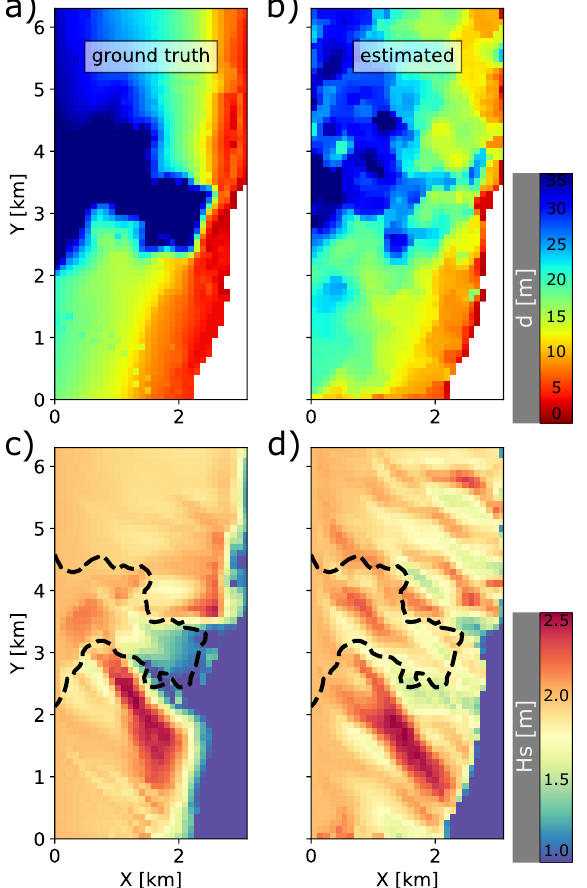
Figure 7. Predicted wave height distributions over ground truth bathymetry and estimated bathymetry of Capbreton using a numerical wave model: ( a , b ) ground-truth depths and estimated depths, respectively, used in the model, where red/blue indicate shallow/deep regions (top colorbar). Salt-and-pepper noise has been removed from ( b ) using a 3 × 3 median filter; ( c , d ) significant wave height distribution associated to ( a , b ), respectively, where red/blue indicate high/low wave heights (bottom colorbar). The 35m depth contour is superimposed to outline the location of the canyon. Hydrodynamic field conditions with H s = 2m, T p = 11s and wave direction = 315° measured by a local buoy (see Figure 3) during satellite overpass are used as boundary